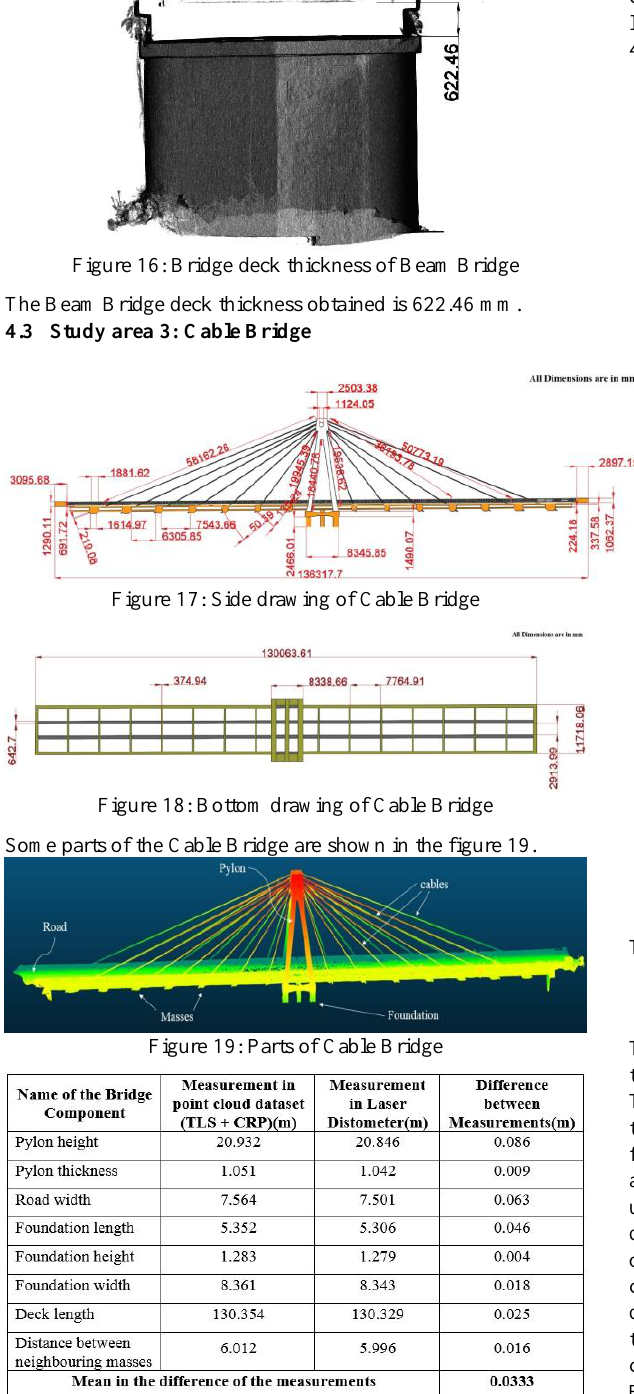
Table 5: comparison of measurements of Cable Bridge